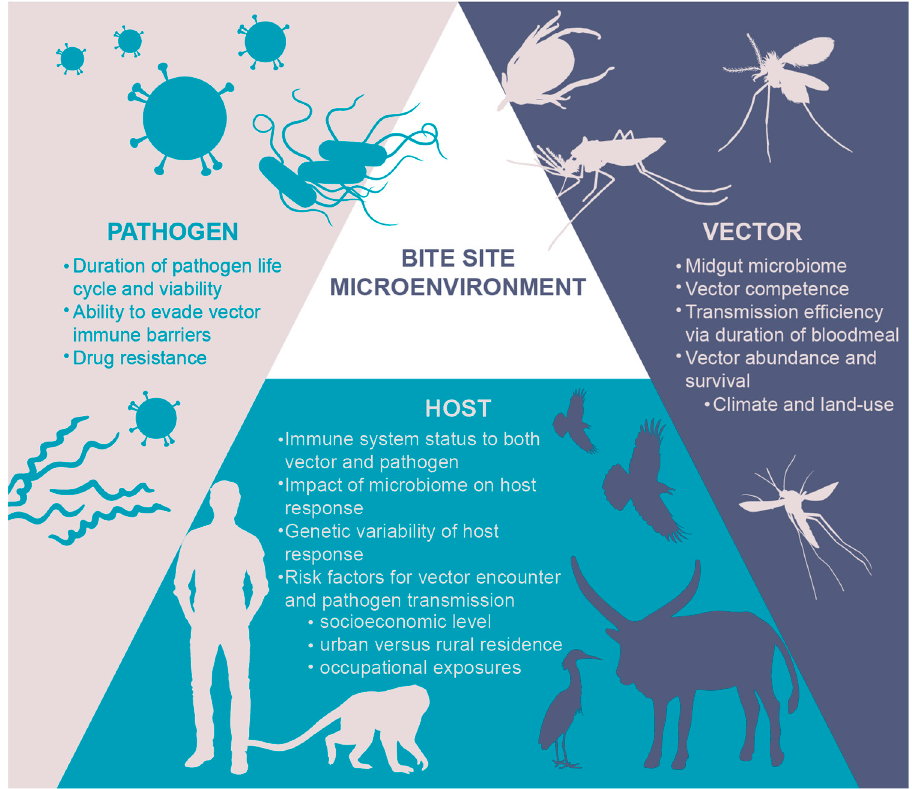
Figure 1. Vector-host-pathogen triad of exposure and interaction.